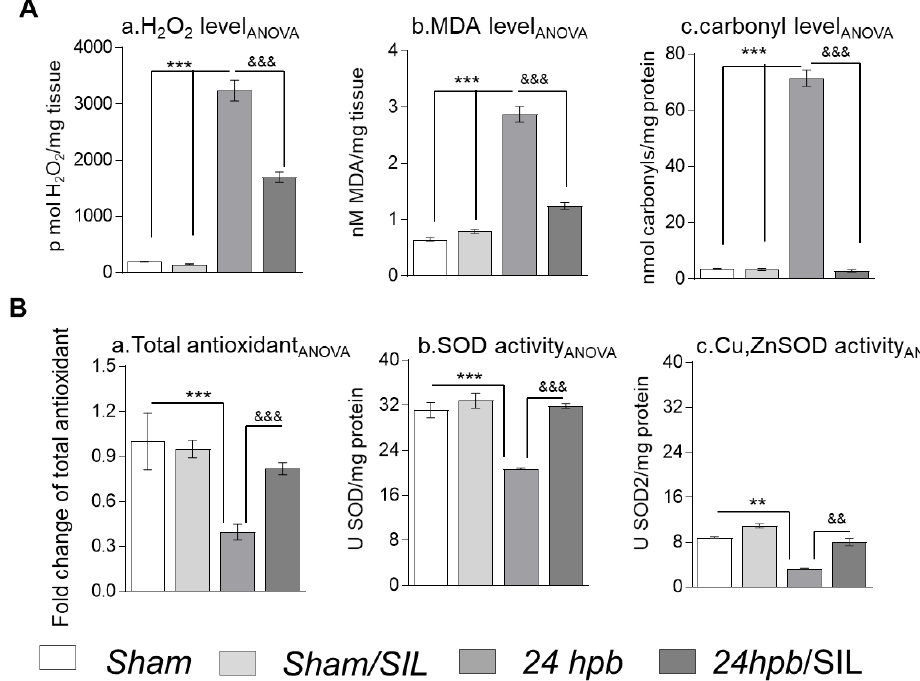
Figure 6. The effect of PDE5 inhibition on oxidant/antioxidant imbalance. Sprague–Dawley rats were randomized to a 60% TBSA scald burn or sham procedure with standard resuscitation with/without sildenafil (SIL). Heart tissues and blood were harvested at 24 h post burn (24 hpb ± SIL). ( A ) Shown are H 2 O 2 levels (a), MDA levels (b) and protein carbonylation (c) in myocardium after burn. ( B ) Shown are cardiac antioxidants, including total antioxidant (a), total SOD activity (b) and Cu,ZnSOD activity (c) after burn. Results were normalized to rat GAPDH and β-actin mRNAs, and represent fold change after burn (±SIL), as compared to that noted in matched normal controls. In all figures, data are plotted as mean value ± SD. Significance is shown as * (24 hpb vs. control) or & (24 hpb vs. 24 hpb/SIL), and presented as ** , && p < 0.01, *** , &&& p < 0.001 (n = ≥ 6 per group).